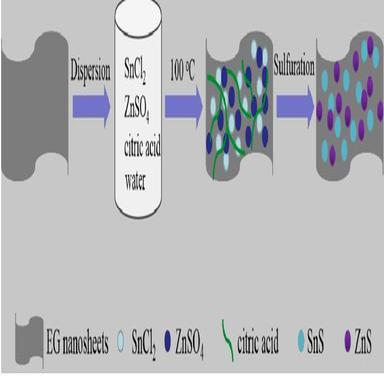
Schematic illustration for the synthesis of ZnS-SnS@C/EG composite.